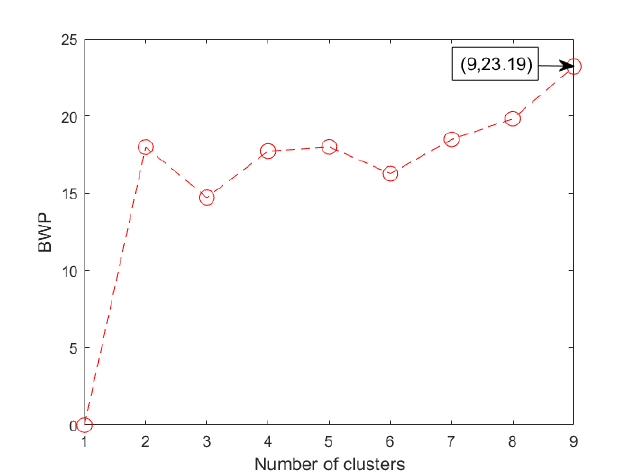
Figure 3. Cluster Validity Analysis of the proposed method with different values of